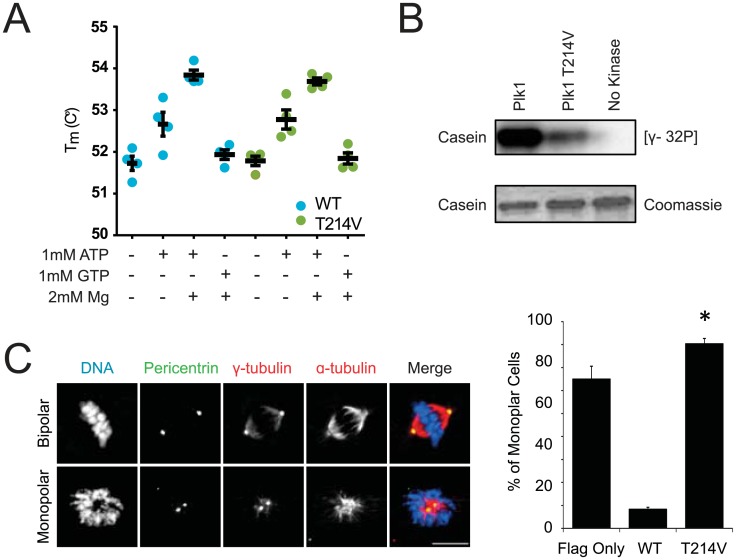
Plk1 T214V does not rescue Plk1 functions.(A) Plk1 T214V is not unfolded and can bind ATP. Recombinant His-tagged Plk1 kinase domains with and without T214V mutation were assessed for proper protein folding using Differential Scanning Fluorimetry. Equivalent conditions except where indicated. n = 3 (B) Recombinant His-tagged kinase domain of Plk1 with or without T214V mutation and α-casein were incubated with [γ-32P], resolved by SDS-PAGE, and visualized by autoradiography. (C) Cells shown were treated with 3-MB-PP1 for 6 hours, fixed, and stained with DAPI and for pericentrin, γ-tubulin and α-tubulin. n = 3, 300 or more cells were counted for each cell line. *p<0.05 compared to incidence of monopolar spindles in GFP-Plk1AS/Flag-Plk1WT cells. Scale bar, 10μm.